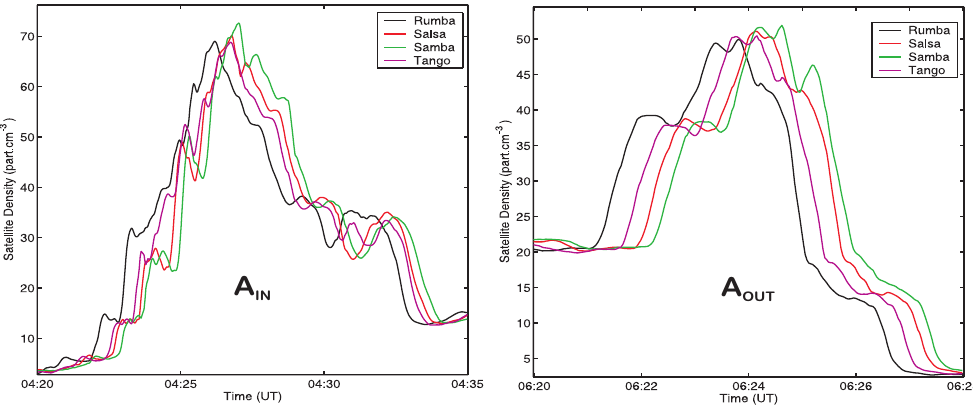
Fig. 5. Electron density profiles as a function of time of the two plume crossings A IN and A OUT observed on the inbound and outbound legs of the plasmasphere crossing on 11 April